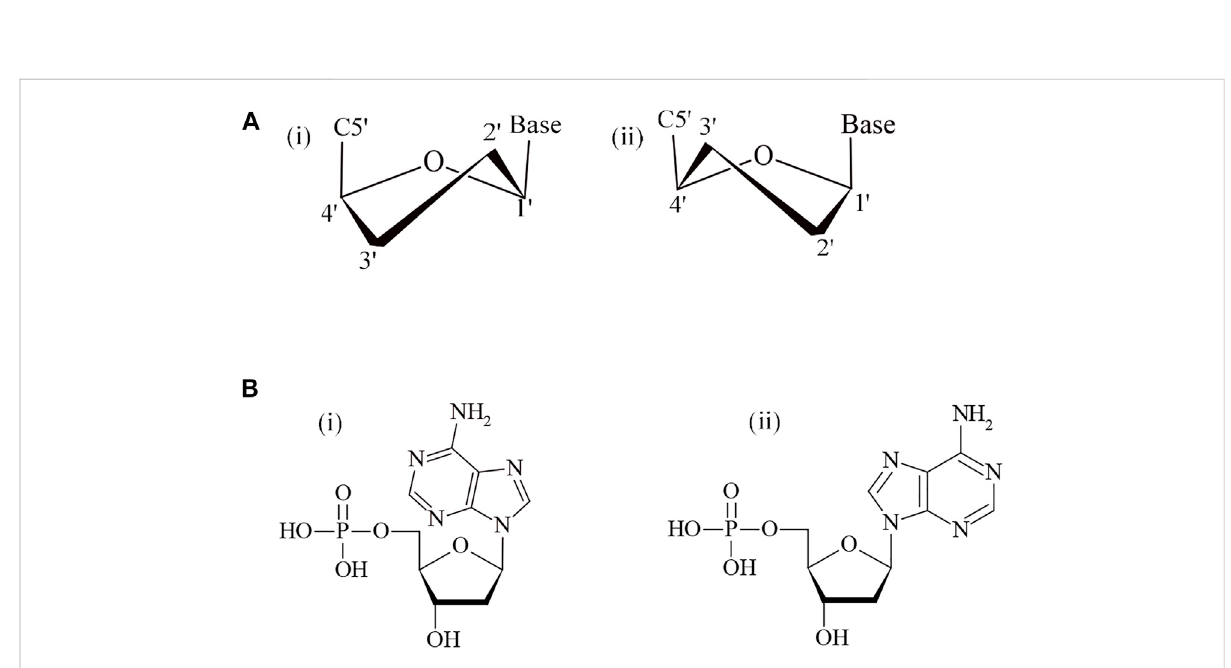
anti and the sugar conformation is C2 ′ -endo, whereas in the A-form DNA the sugar conformation is generally C3 ′ -endo (Figure 2A). The Z-DNA, a structure favored by alternating GC-rich sequences, is different from A- and B-form DNAs as the purine (G) here adopts a syn orientation withC3 ′ -endopucker, whereas the pyrimidine residue (C) acquires anti-conformation and the sugar adopts the C2 ′ -endo pucker (Figure 2B). The variation in sugar pucker and orientation of N-glycosidic bond affects the shape of duplex, widths, and depths of grooves,